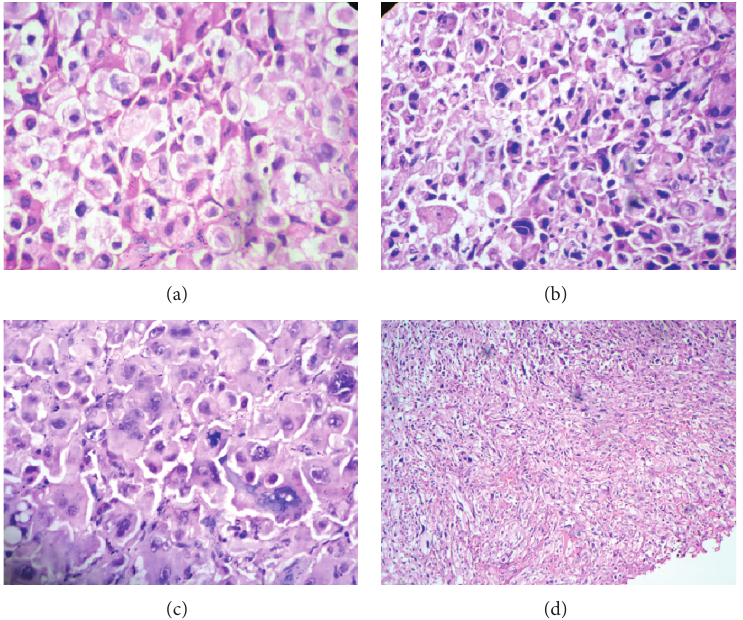
Figure 2: (a) Photomicrograph of amelanotic melanoma shows diffuse proliferation of large ovoid to polygonal tumor cells with pale eosinophilic granular cytoplasm and eccentrically placed nucleus (H&E 40x). (b) Nuclear pleomorphism and increased nucleocytoplasmic